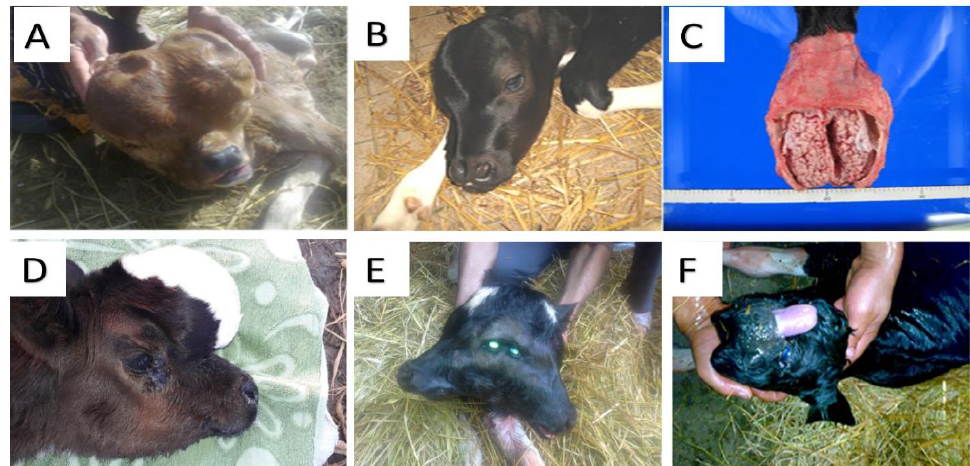
Fig. 4: Gross pictures showing congenital head malformations: hydrocephalus in two calves Brown Swiss (A) and mixed breed (B). Coronal section of the skull in mixed breed calf showing dilated brain ventricles upon dissection (C). Meningeocele (D), double head (E) and cyclopia (F) were seen in mixed breed calves.